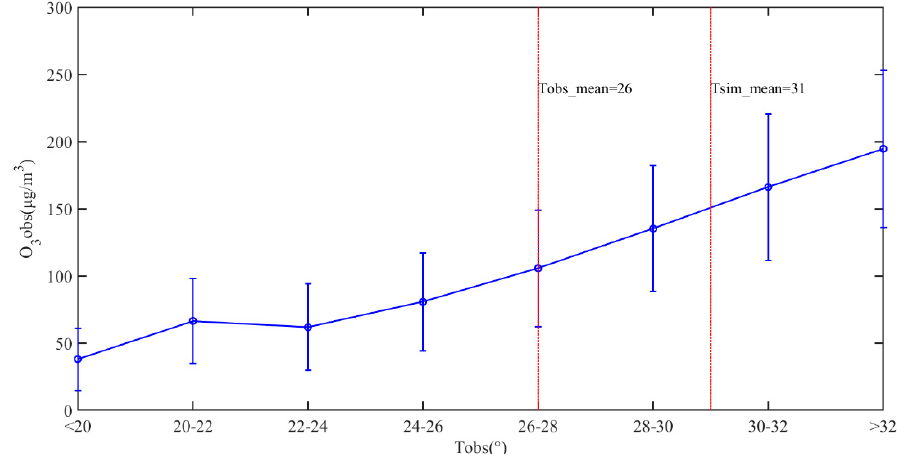
Figure 5. The observed O 3 concentration under different levels of observed air temperature with the range of 20–32 °C; the two red lines represent the averaged observed air temperature and averaged simulated temperature, respectively.